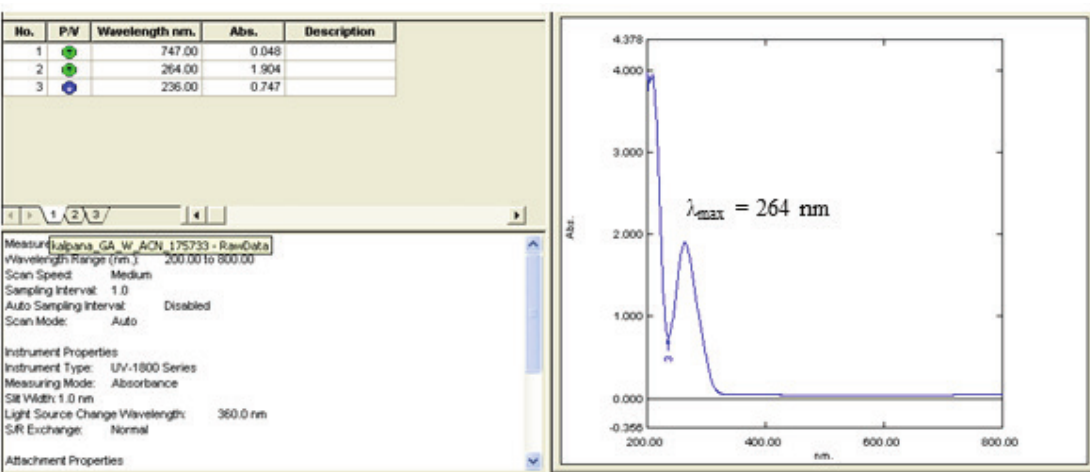
Fig. S4 – Absorption spectra of gallic acid showing l Fig. S3 Absorption spectra of gallic acid showing (cid:31) max = 264 nm *-*-*